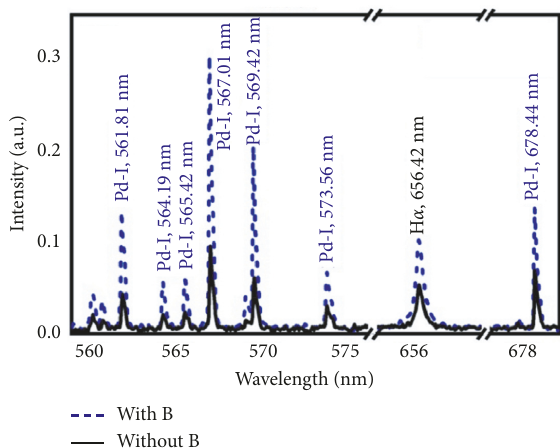
Figure 7: Optical emission spectrum of palladium for laser fluence of 12.6J/cm 2 recorded before and after applying magnetic field